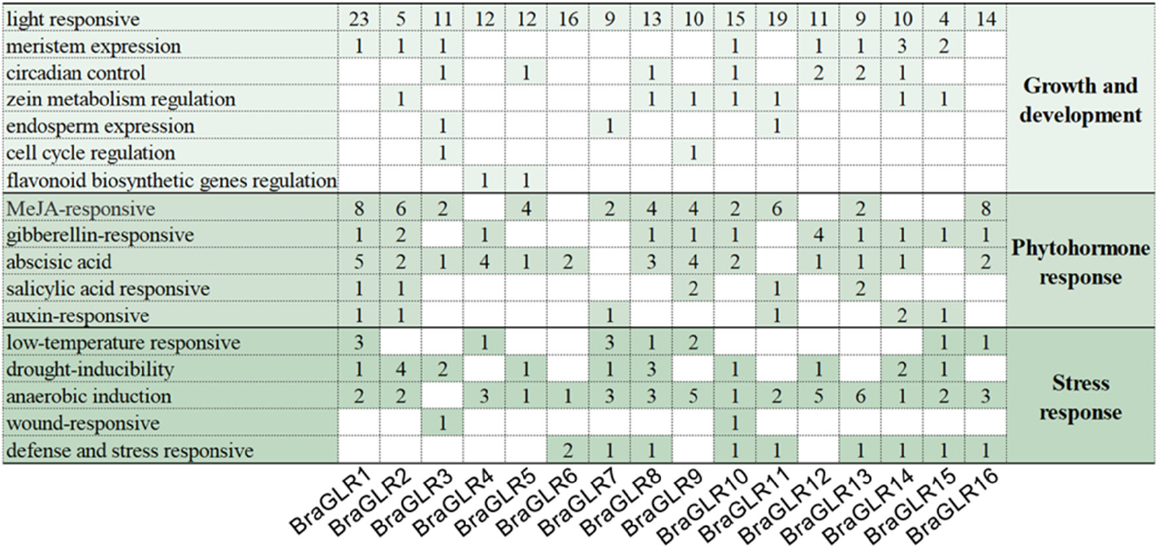
Figure 3. Analysis of cis elements in promoter of GLR genes in B. rapa .